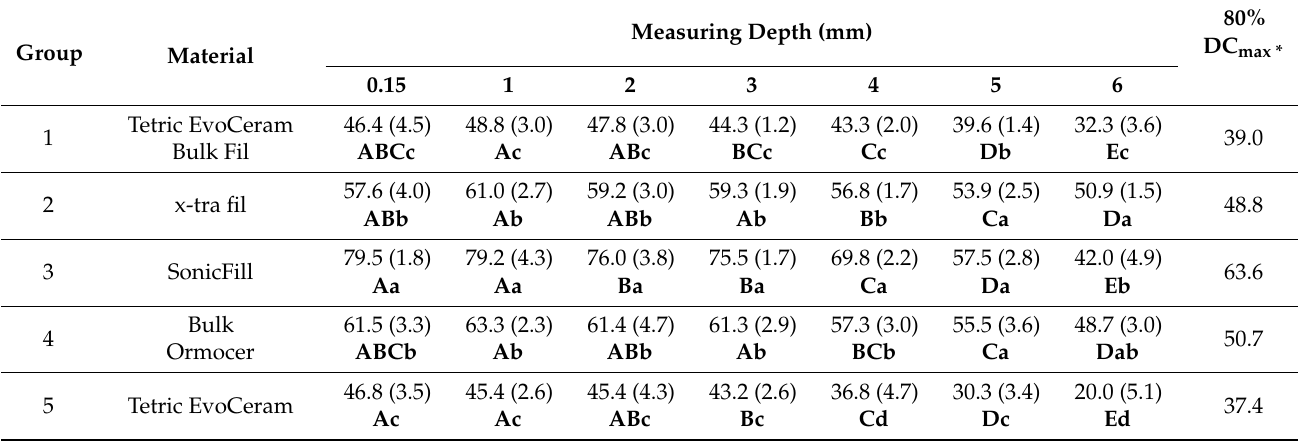
Table 2. Mean ( ± standard deviation) degree of conversion (DC, in %) of the tested composites at different measurement